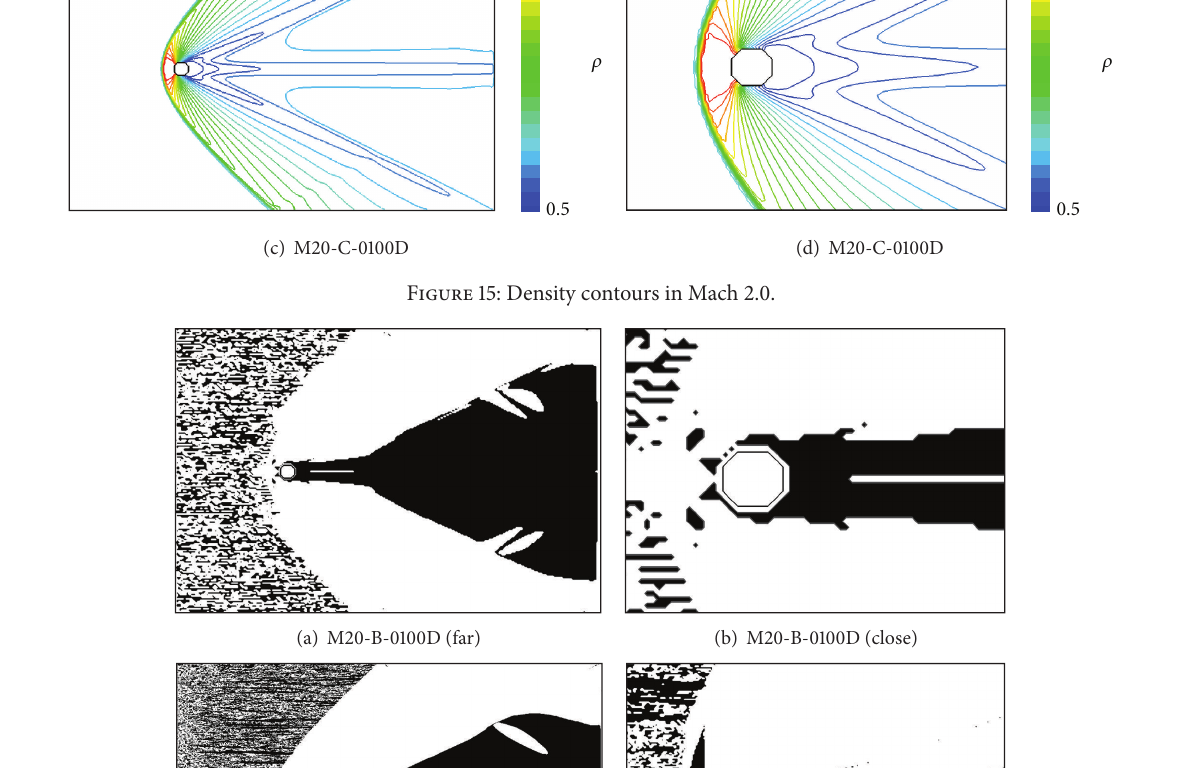
Figure 15: Density contours in Mach 2.0.